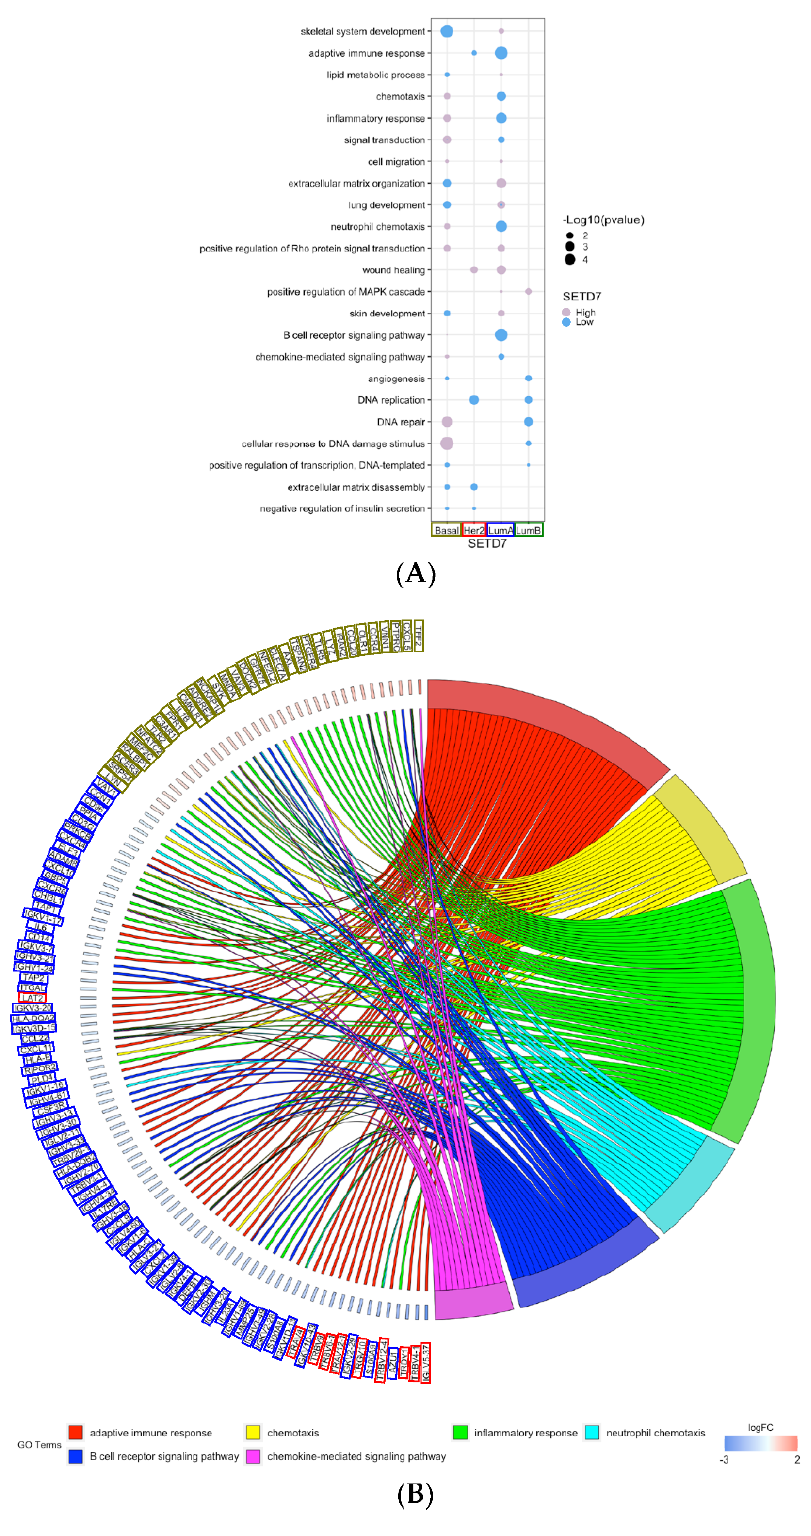
Figure 4. Analysis of the shared biological processes overrepresented among the differentially expressed genes associated with SETD7 (high and low) and unique for each subtype. ( A ) Bubble plot representing all shared biological processes from the unique genes for each subtype; ( B ) GoChord showing all unique genes representing shared immune-related biological processes.